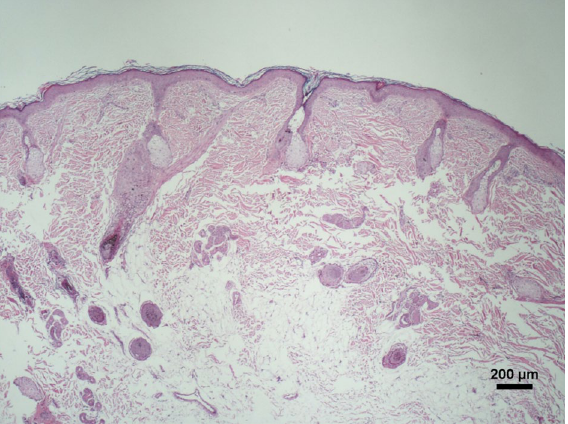
Figure 3. Vertical section of skin biopsy of a macaque (No. 2016080403) with symmetrical alopecia showing no infiltration of inflammatory cells or pathogen infection in skin tissues.